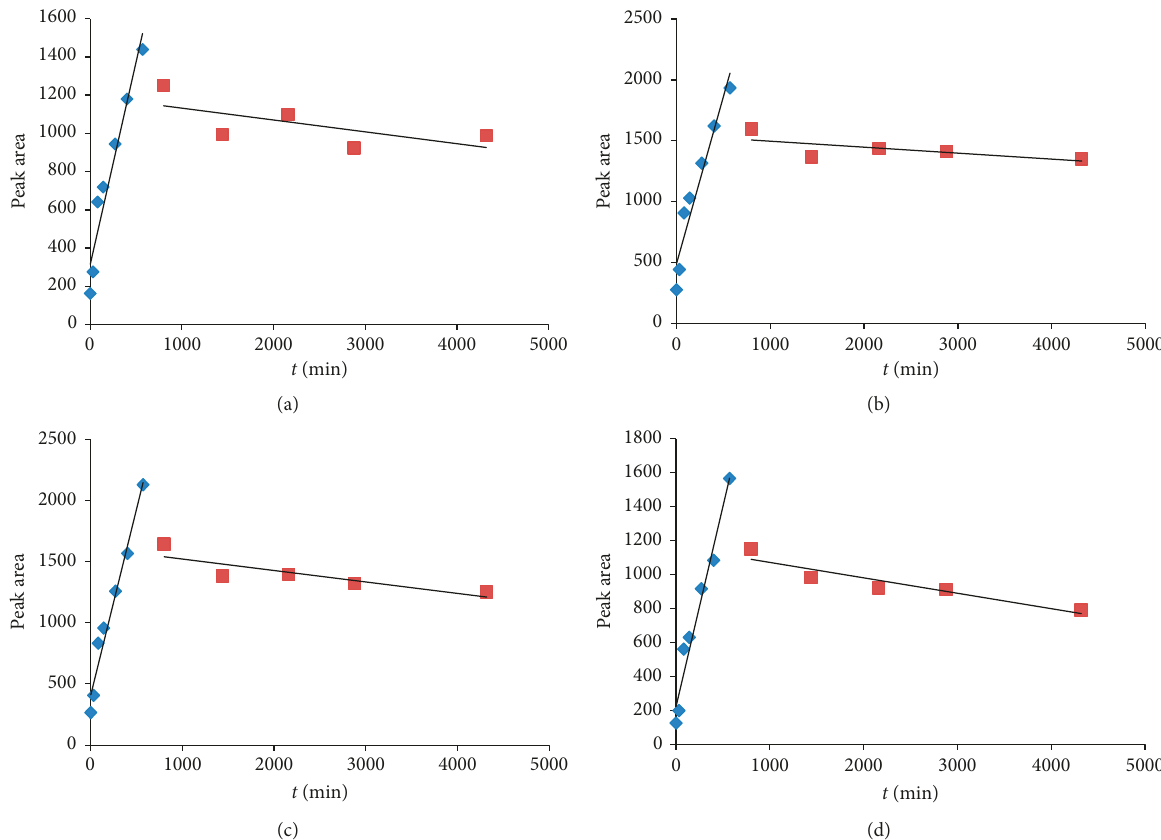
Figure 4: The variation of the content of each characteristic component with time. (a) Rhynchophylline , (b) isorhynchophylline , (c) corynoxeine , and (d) the sum of peak areas.